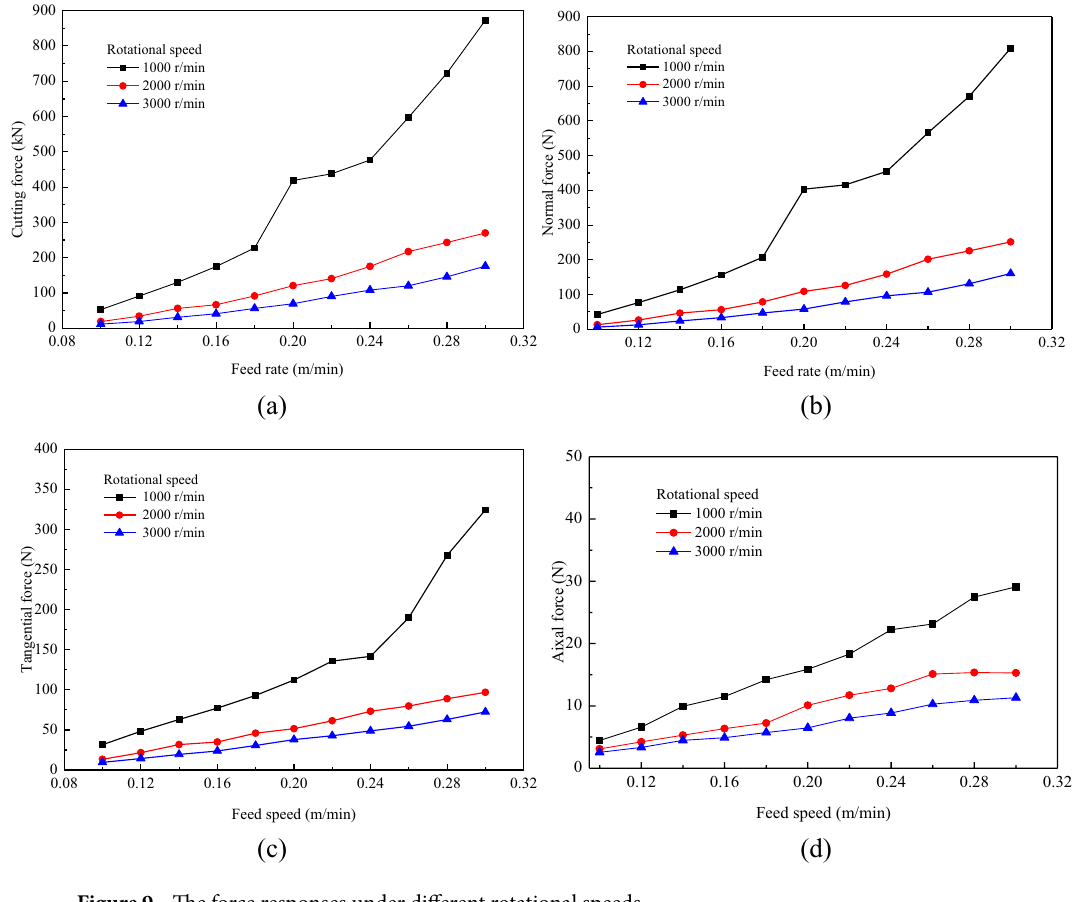
Figure 9. The force responses under different rotational